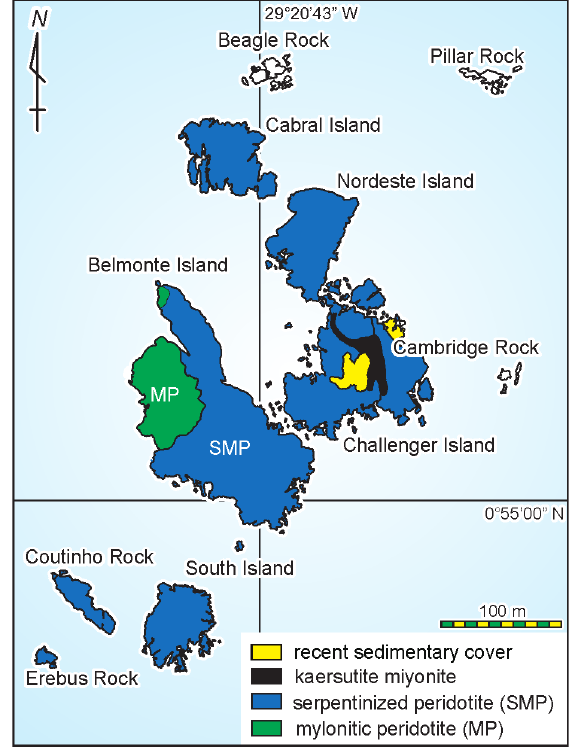
Figure 3 - Geologic map of the Saint Peter and Saint Paul Rocks, Equatorial Atlantic Ocean, after Campos et al.